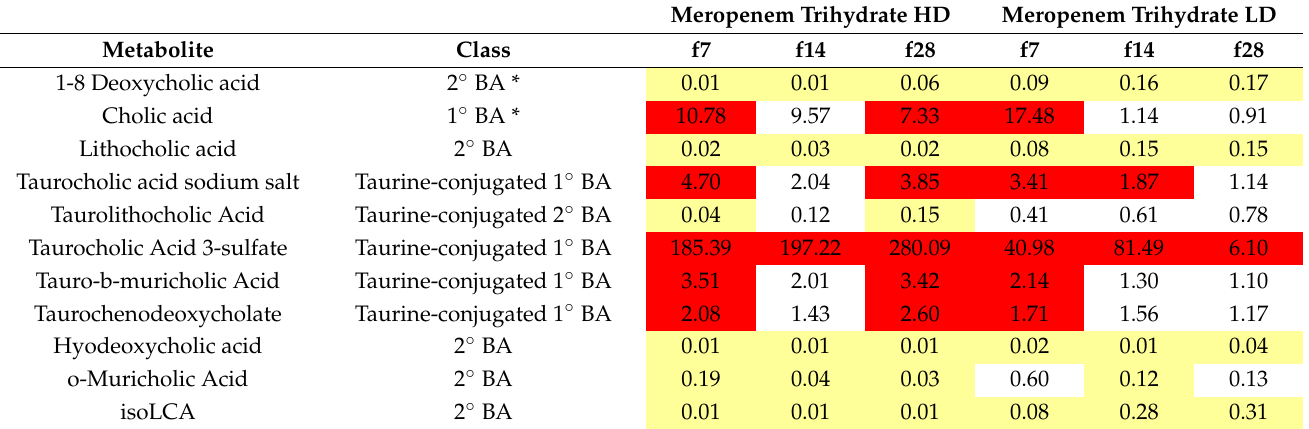
Table 2. Meropenem-induced BA fold changes in feces of female (f) Wistar rats (N = 5 per group) dosed with 100 (LD) and 300 (HD) mg/kg bw/day observed on days 7, 14, and 28 (f7, f14, and f28). Statistically significant changes (Welch t -test; p -value < 0.05) are shown where red boxes mean a significant increase, yellow boxes mean a significant decrease, and white boxes indicate an insignificant change in the respective fecal